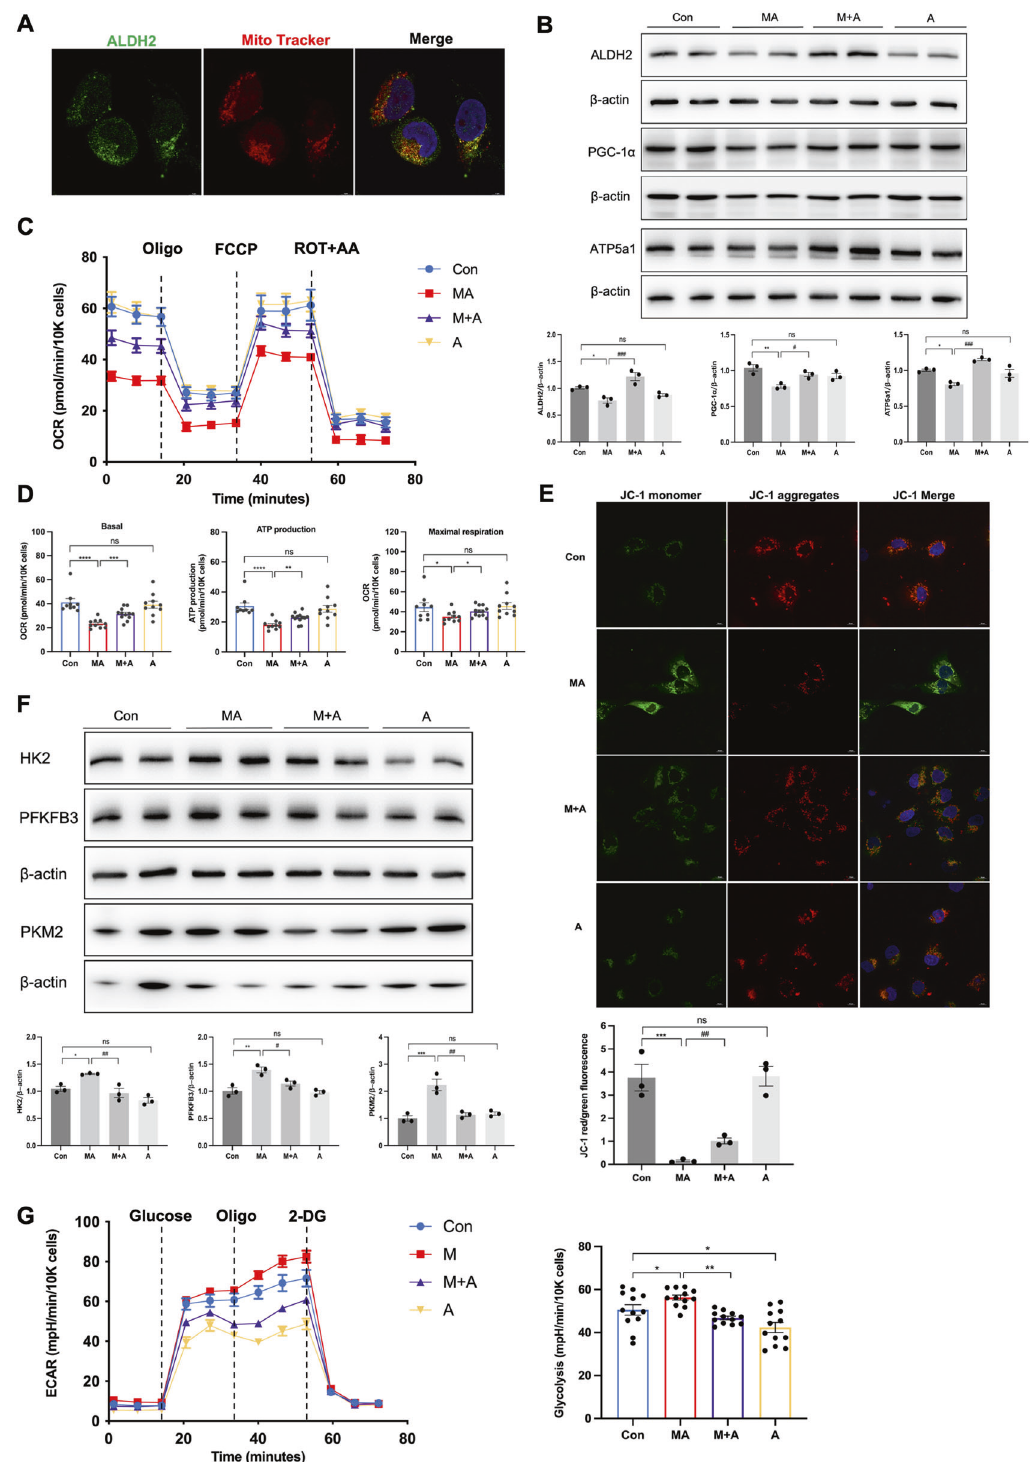
Fig. 5 ALDH2 activation attenuated mitochondrial dysfunction in MA-treated HK-2 cells. A Immuno fl uorescent analysis of the colocalization between ALDH2 and mitochondria (indicated by Mito Tracker) in HK-2 cells ( n = 3). Scale bars, 20 μ m. B The expression of mitochondria-related proteins (ALDH2, PGC-1 α and ATP5a1) was measured by western blotting ( n = 3). C , D Measurement of mitochondrial oxygen consumption ratio (OCR) in HK-2 cells ( n = 9 – 12 each group). E Images of JC-1 staining for mitochondrial membrane potential in 4 groups ( n = 3). Scale bars, 20 μ m. F The expression of aerobic glycolysis-related enzymes (HK2, PFKFB3 and PKM2) was measured by western blotting ( n = 3). G Measurement of mitochondrial extracellular acidi fi cation rate (ECAR) in HK-2 cells ( n = 12 each group). * P <0.05, ** P <0.01,*** P <0.001, **** P < 0.0001; # P <0.05, ## P <0.01, ### P <0.001, #### P <0.0001; ns not signi fi cant. (Con Control, MA maleic acid, M + A maleic acid + Alda-1, A Alda-1, OCR oxygen consumption ratio, ECAR extracellular acidi fi cation rate, Oligo oligomycin, ROT + AA rotenone/antimycin A).